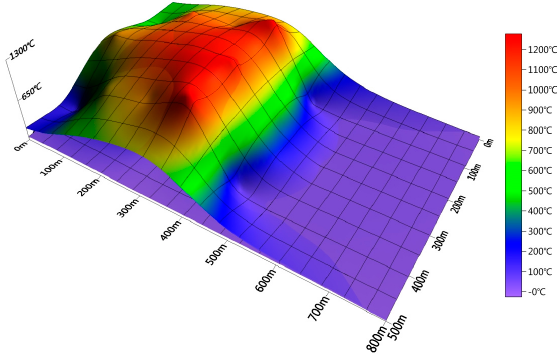
Figure 6. Temperature profile distribution during UCG simulation test (60%-O 2 ).